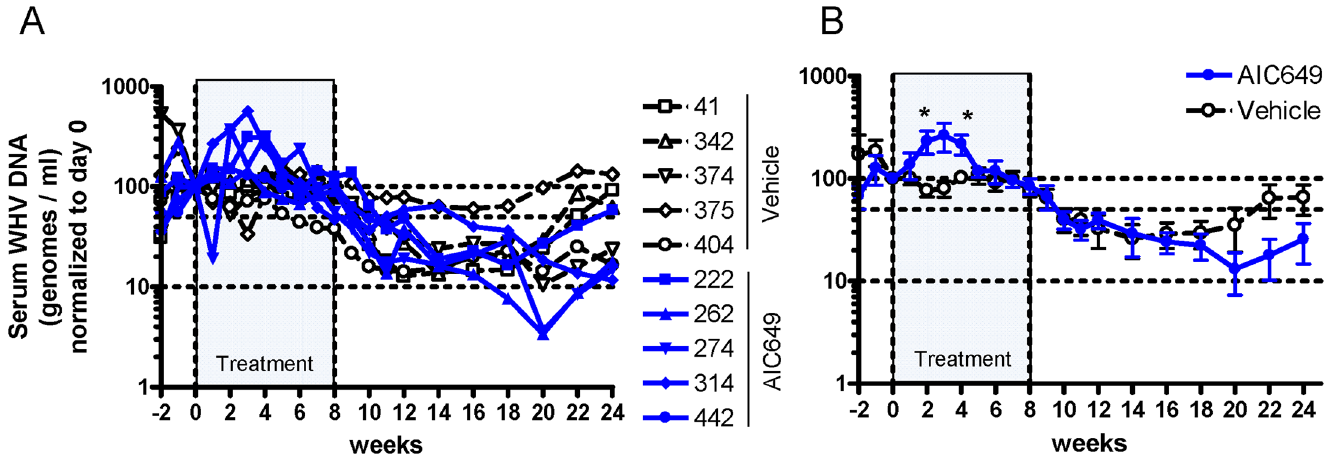
Fig 3. AIC649 induces a bi-phasic treatment effect on viremia levels in chronic WHV carrier woodchucks. AIC649 (3.9 x 10 6 Units (ELISA-based titer)) or vehicle were administered i.m. twice weekly for 8 weeks (marked “ Treatment ” ). At the indicated time points woodchucks were bled and serum was subjected to determination of WHV viral load. Values were normalized to individual baseline at day 0 and are given in %. n = 5 / group. Dotted lines: 100%, 50%, or 10% level. (A) Serum WHV DNA concentrations of individual woodchucks (identified by numbers) in the vehicle and AIC649 groups. (B) Group means of WHV DNA concentration +/- standard error of the mean (SEM). * p < 0.05.